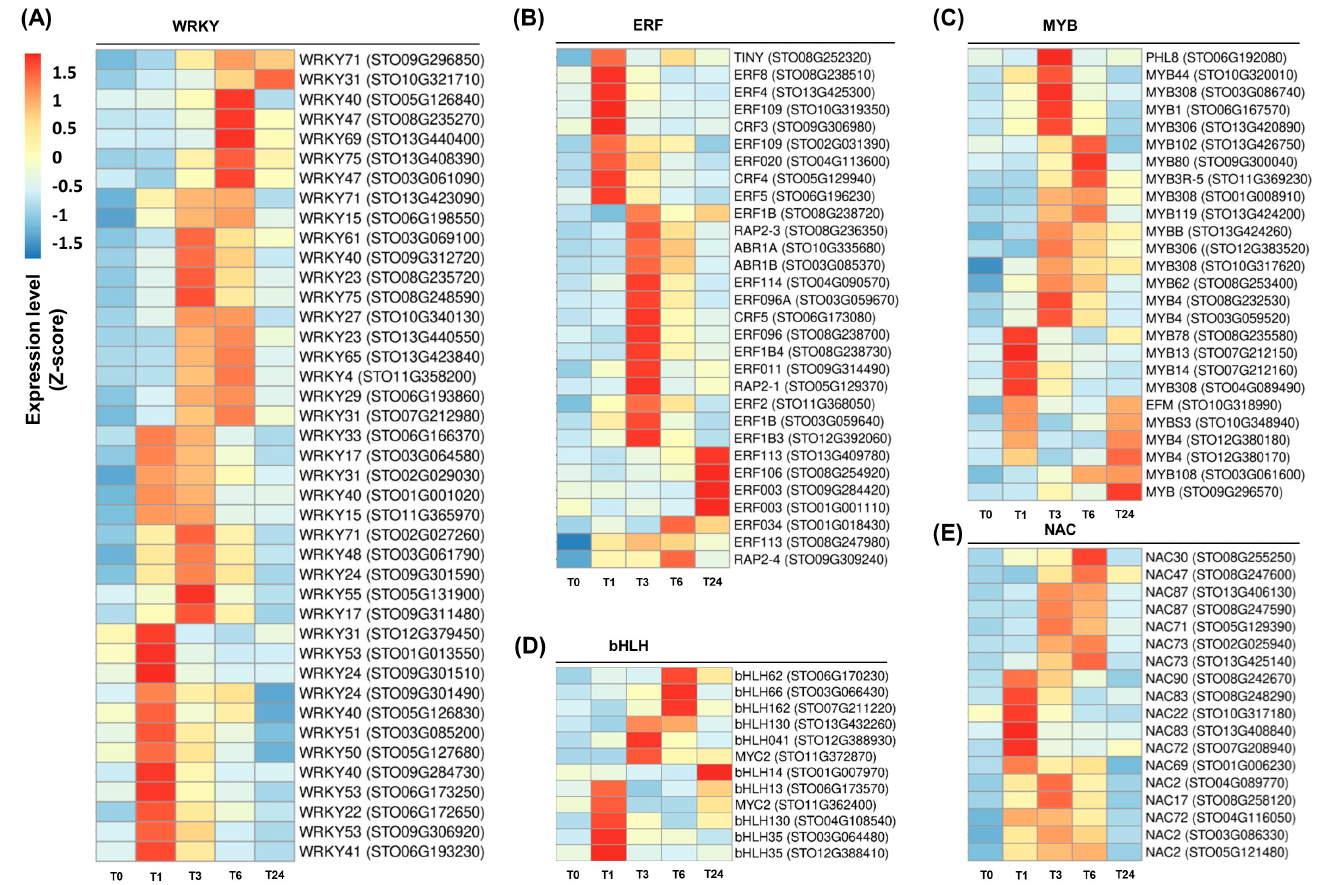
Figure 5. Induction of transcription factor (TF)-encoding genes following wounding in S . tora leaves. ( A – E ) Heatmap analysis of genes encoding WRKY ( A ), ERF ( B ), MYB ( C ), bHLH ( D ), and NAC ( E ) TFs. The fragments per kilobase of transcript per million mapped reads (FPKM) value for each individual gene was normalized to the Z-score. The heatmap was visualized using the pheatmap package in R. Statistical analysis was performed on the expression levels of each gene expressed at the different times compared with T0 (Table S3).